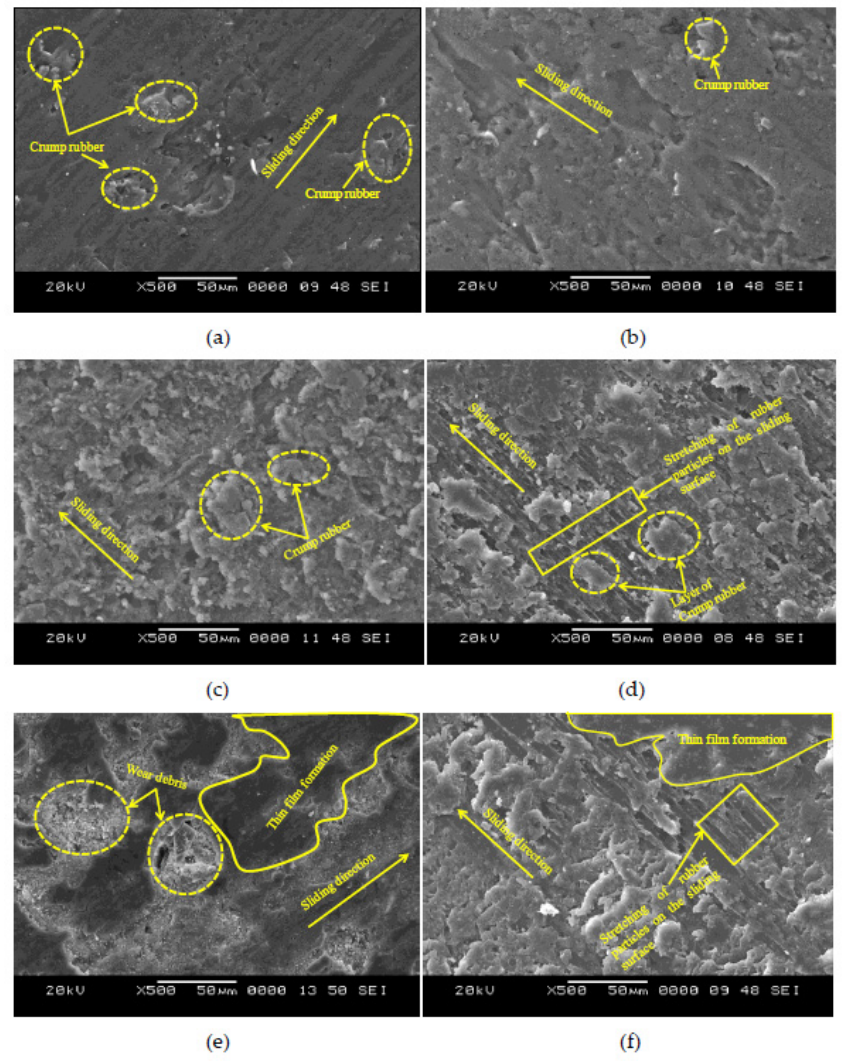
Figure 10. Scanning electron micrographs of EC-10 at ( a ) 30 and ( b ) 50 N; EC-20 at ( c ) 30 and ( d ) 50 N; and EC-30 at ( e ) 30 and ( f ) 50 N.